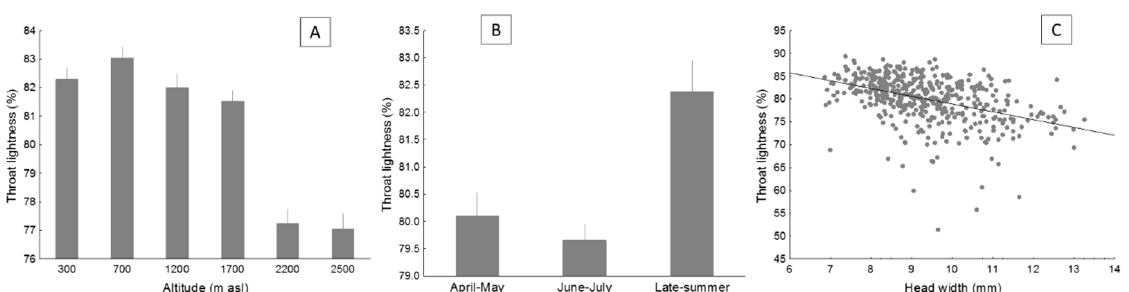
Figure 4. Average values of throat lightness (with SE) in the lizard P. algirus , according to altitude ( A ) and season ( B ), and the relationship between throat lightness and head width ( C ). Notice that raw data are shown, but statistical analyses were performed with transformed data when necessary.